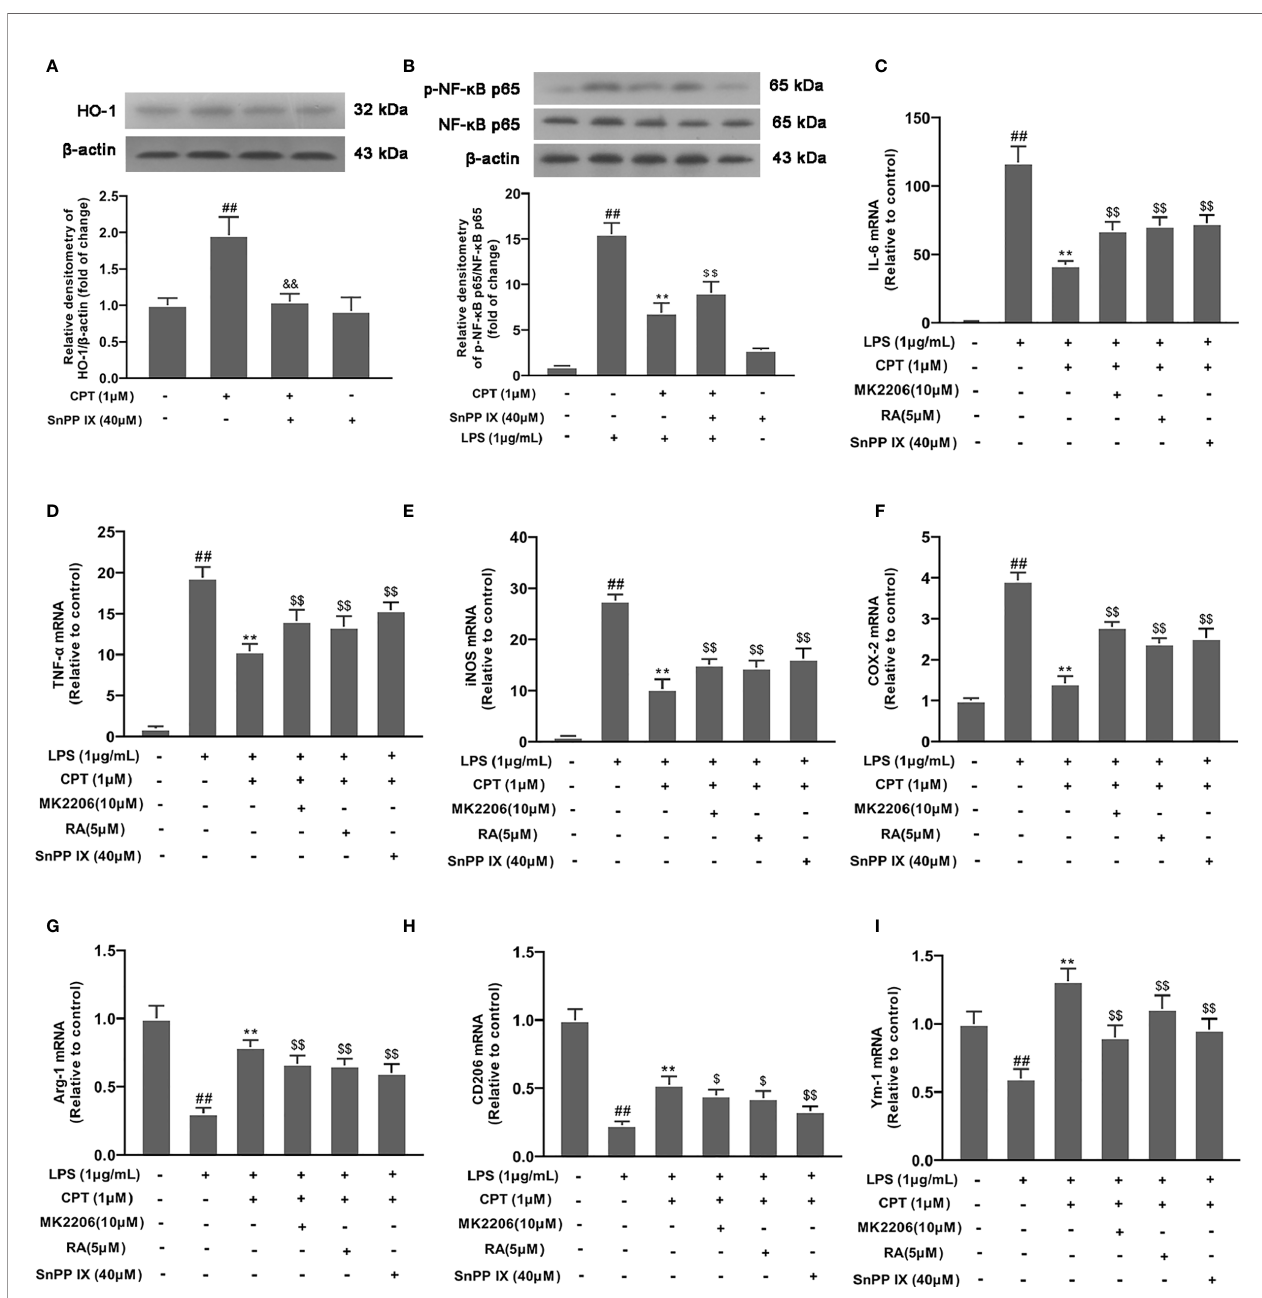
FIGURE 7 | CPT regulates microglial polarization via activating AKT/Nrf2/HO-1 and inhibiting NF- k B pathways. (A) After the cells were treated with SnPP IX (a HO-1 inhibitor, 40 m M) for 3 h and CPT (1 m M) for another 3 h, the protein level of HO-1 was examined by western blot. (B) After SnPP IX treatment, the effect of CPT on NF- k B activation was detected by western blot. (C-I) The cells were treated with different inhibitors (MK2206 for 4 h, RA for 4 h or SnPP IX for 3 h) and CPT (1 m M) for 1 h, then stimulated with LPS for 12 h. The mRNA levels of M1 markers (IL-6, COX-2, iNOS, and TNF- a ) and M2 markers (CD206, Ym-1, and Arg-1) were examined using RT-PCR. Results are shown as means ± SD (n= 5). ## p < 0.01 vs. the no-treatment (NT) group; **p< 0.01 vs. the LPS-exposed group; $ p< 0.05 and $$ p < 0.01 vs. the LPS+CPT-treated